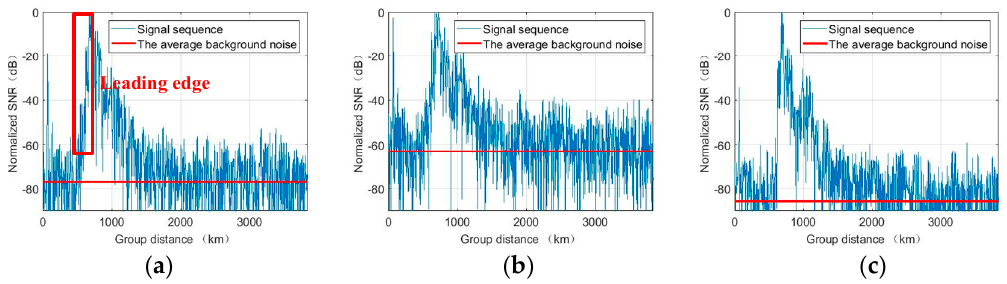
Figure 12. Normalized SNR of 7 MHz; ( a ) Channel 1; ( b ) Directly sum; ( c ) DBF.